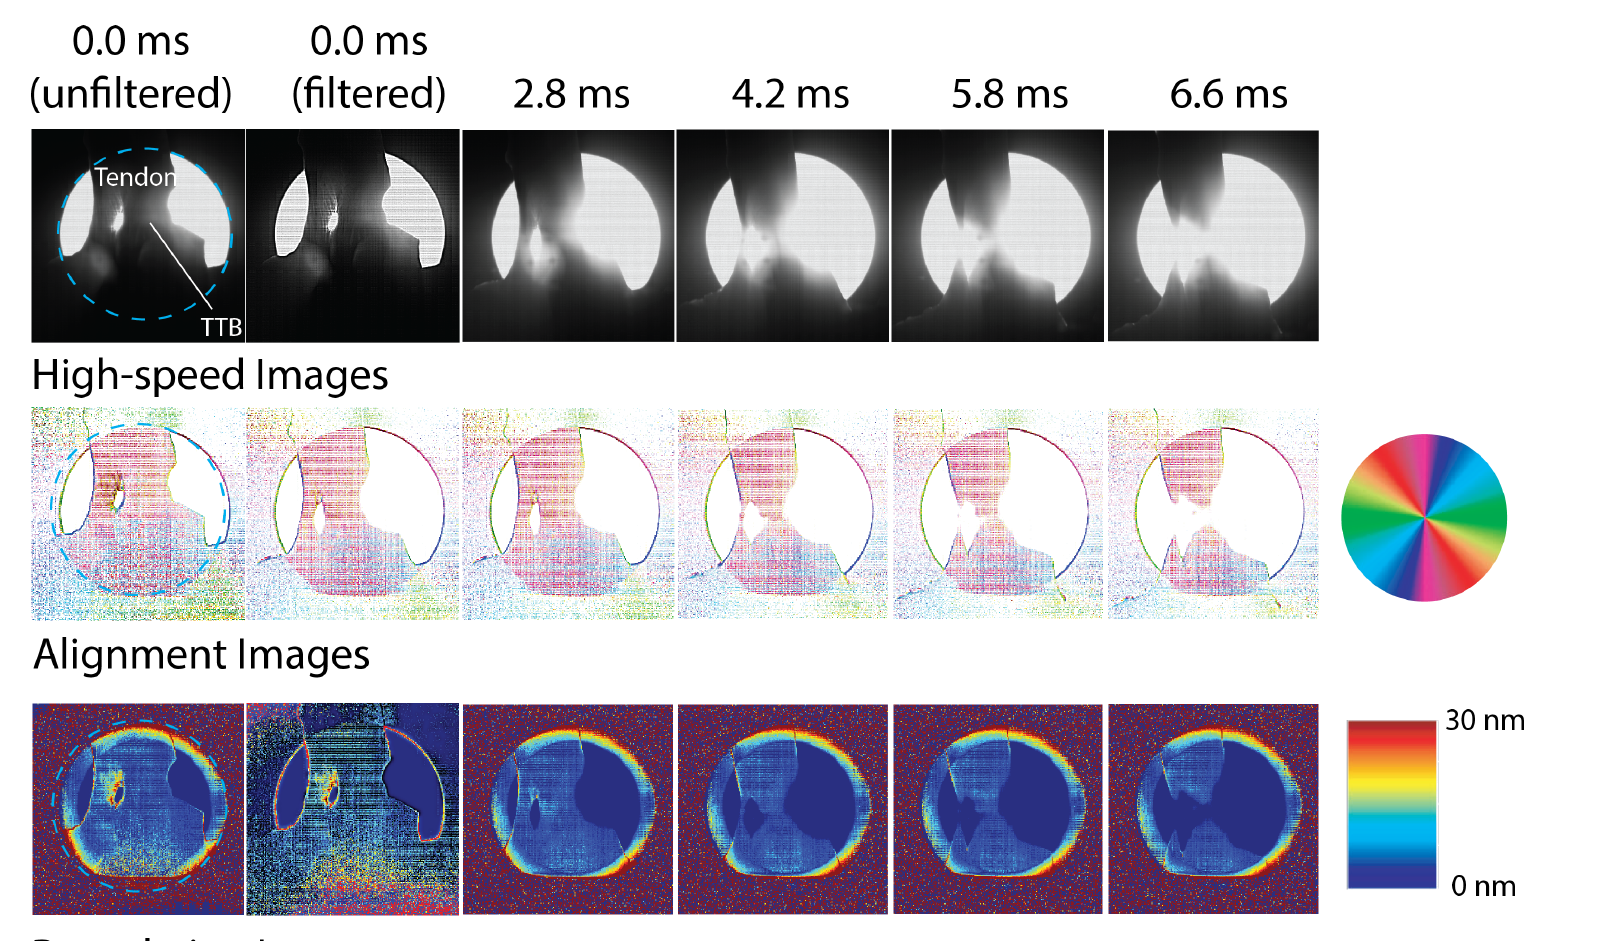
Figure 7. High-speed images recorded for tendon-to-bone insertion specimen 1 using the high-speed polarization-filter-array camera and obtained optical axis alignment angle and retardation images. Field of view is shown as a blue dashed circle in images at 0 ms. Filtered and non-filtered images shown for 0.0 ms. For later time steps, the alignment angle images were filtered; the video and retardation images were